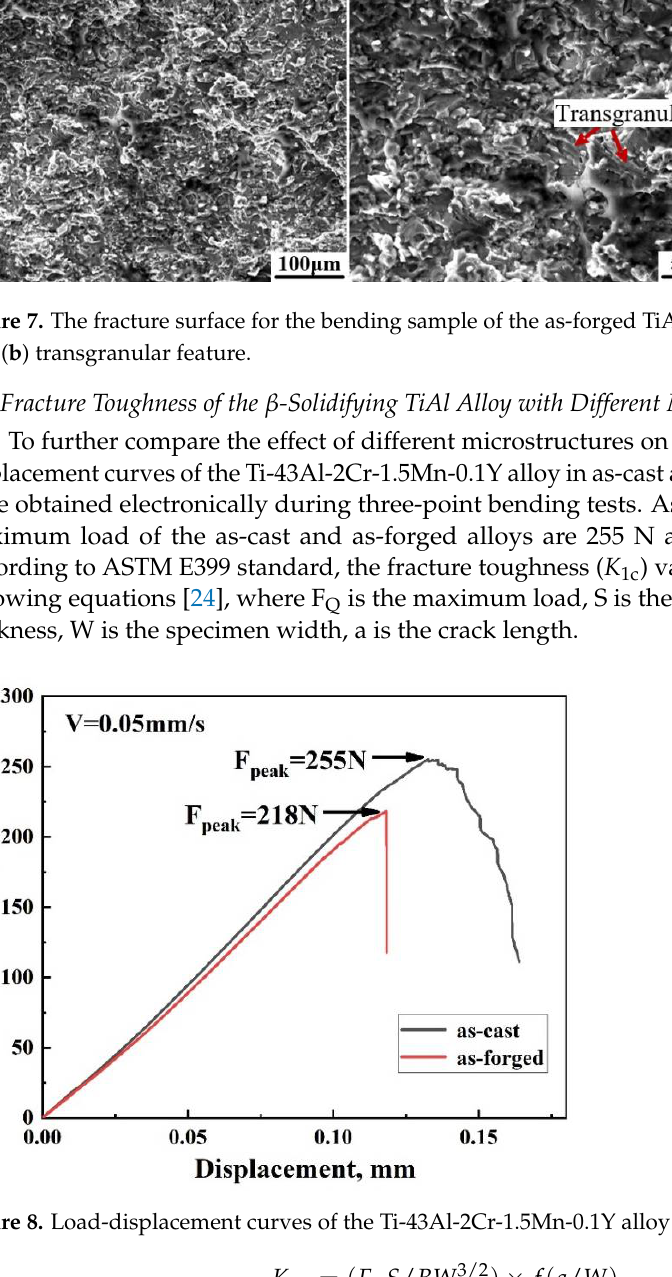
Figure 6. The crack propagation behavior of the as-forged Ti-43Al-2Cr-1.5Mn-0.1Y alloy. ( a ) macro morphology, ( b ) secondary crack and deflection.